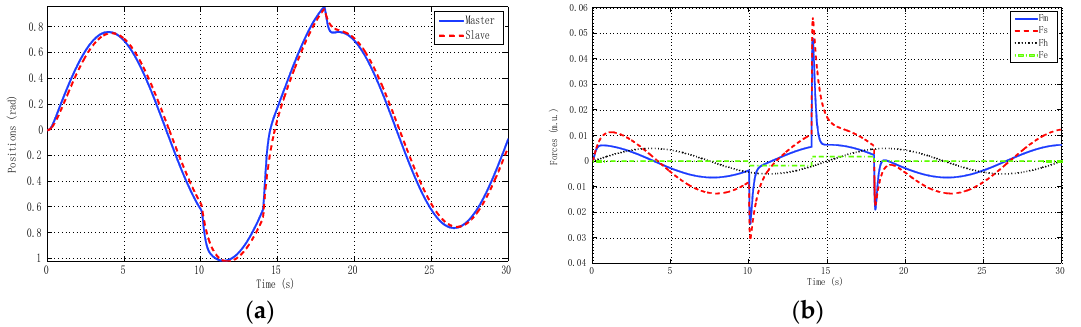
Figure 12. Simulated sine reference force: γ-4C control scheme, Ps ≠ P, with h max = 0, d = 0. ( a ) Positions; ( b ) Forces.